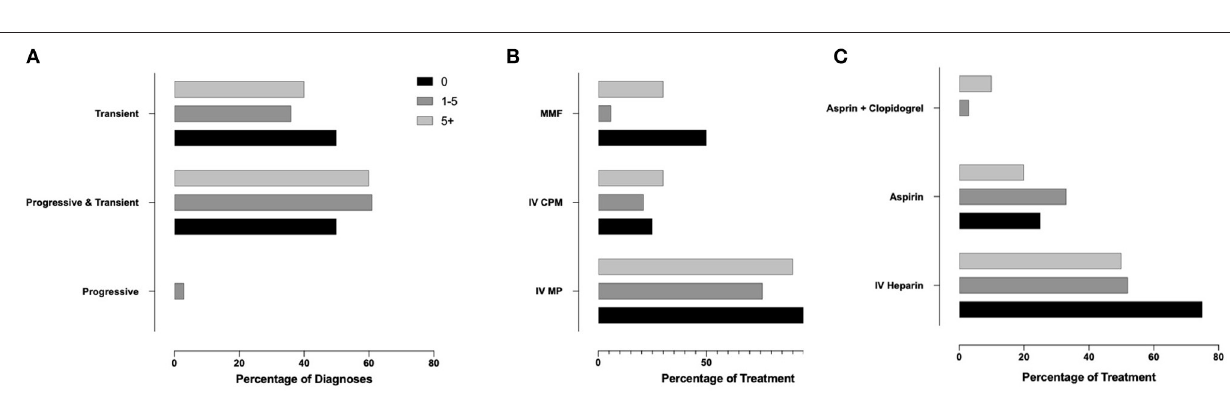
for progressive p-cPACNS. A majority of